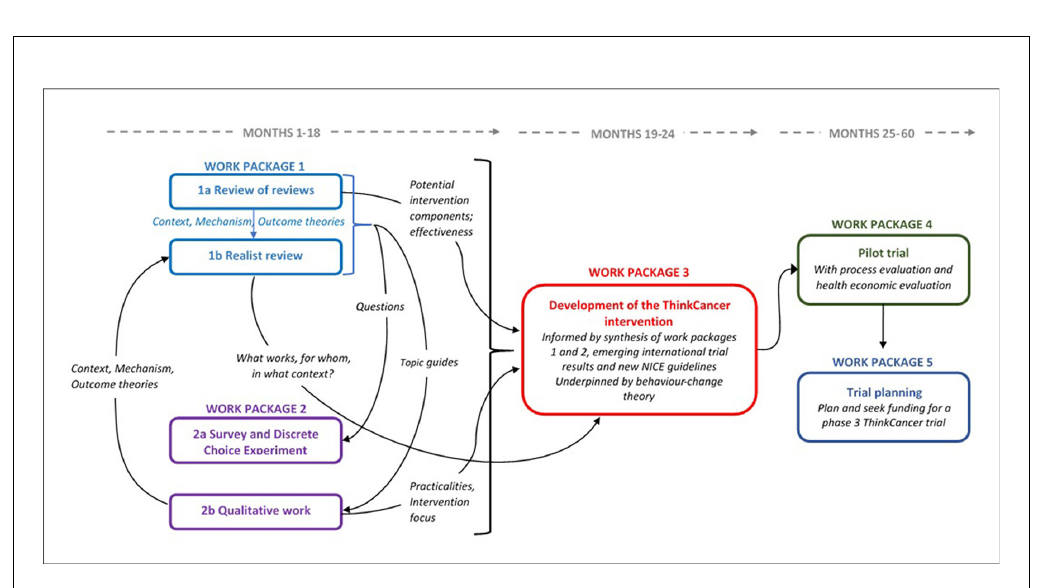
Figure 1. Diagram of the WICKED (Wales Interventions and Cancer Knowledge about Early Diagnosis) research programme